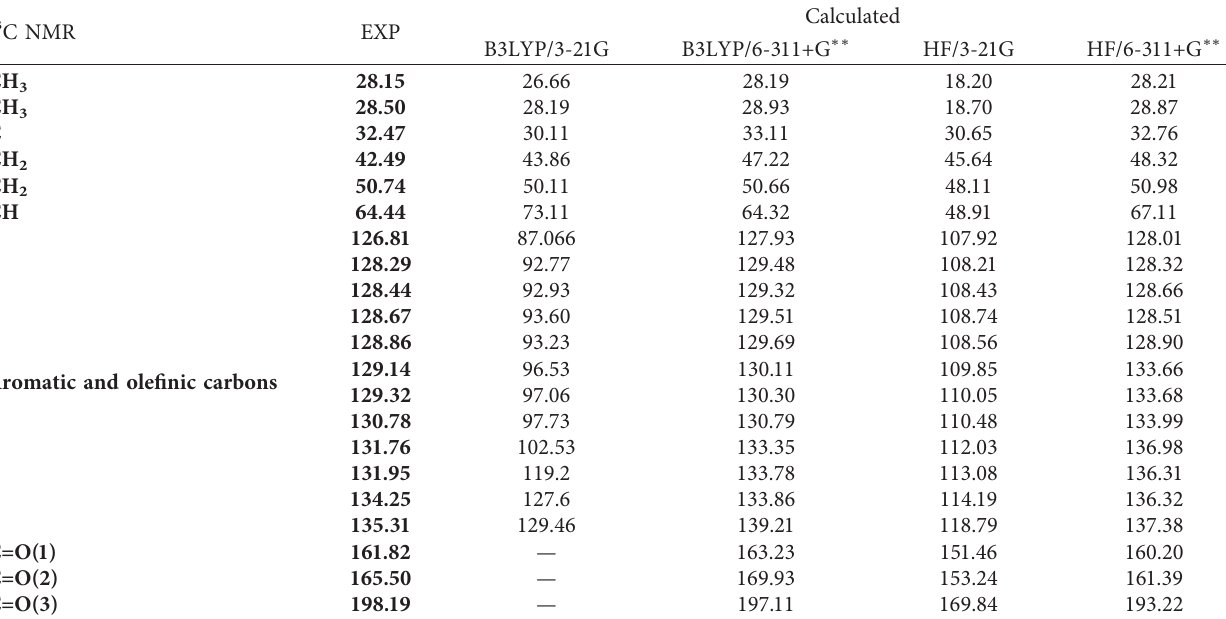
Table 10: Experimentally measured and calculated 13 C chemical shifts δ (ppm vs TMS) of the compound (5c) . 13 C NMR